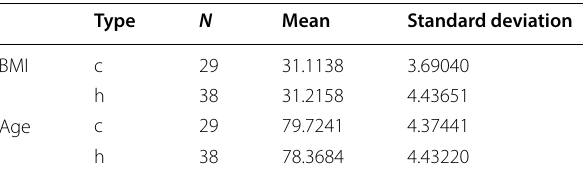
Table 2 BMI and age results for cemented (c) and hybrid (h)